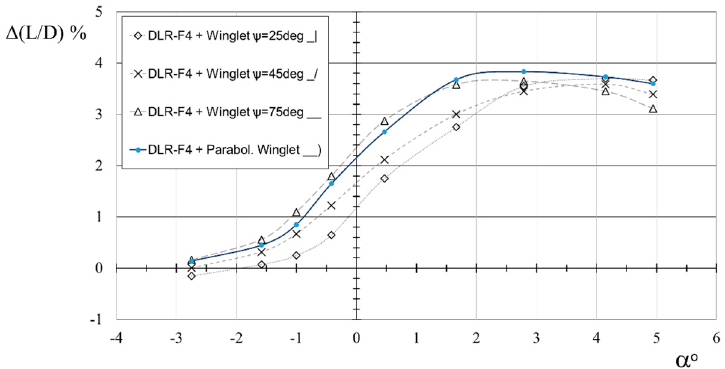
Figure 16. Comparison of overall improvement (%) in L/D ratio of DLR-F4 model equipped with a curved parabolic winglet with conventional winglets at M = 0.75 and different geometric angles of attack of the model.